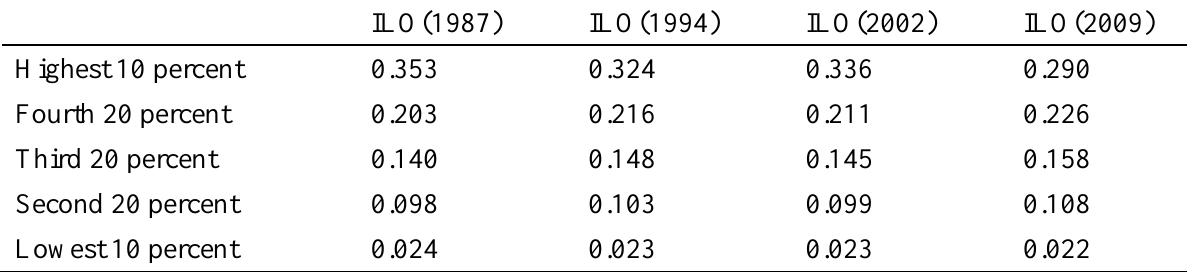
Table 2: Size of Distribution of National Income in Turkey (% of